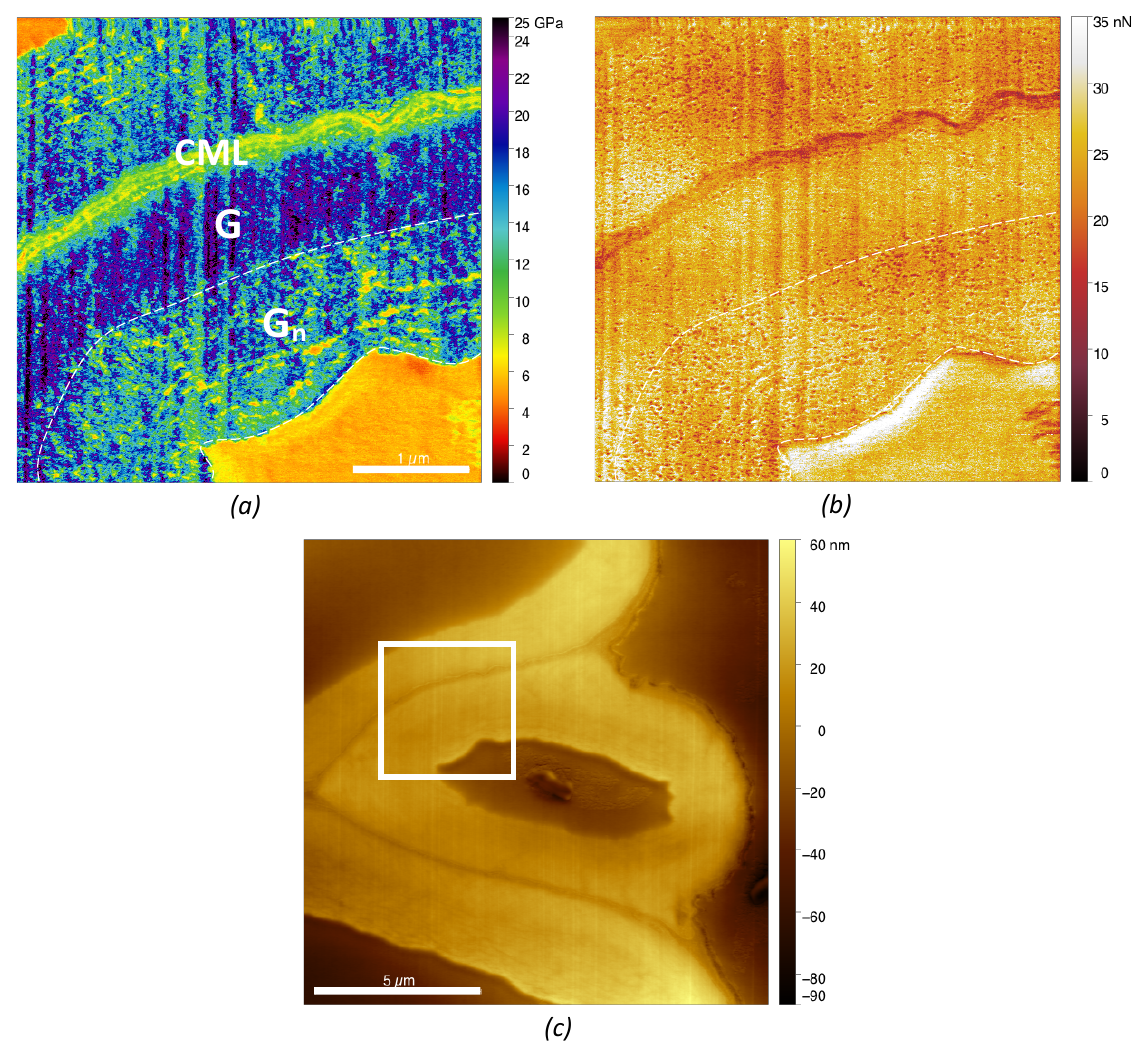
Figure 8 : Comparison of the G and G n -layers in developing flax bast fibre (60 days, half height of the stem) adapted from Arnould et al. (2017): a) indentation modulus map and b) adhesion map corresponding to the white box in the topography image (c).